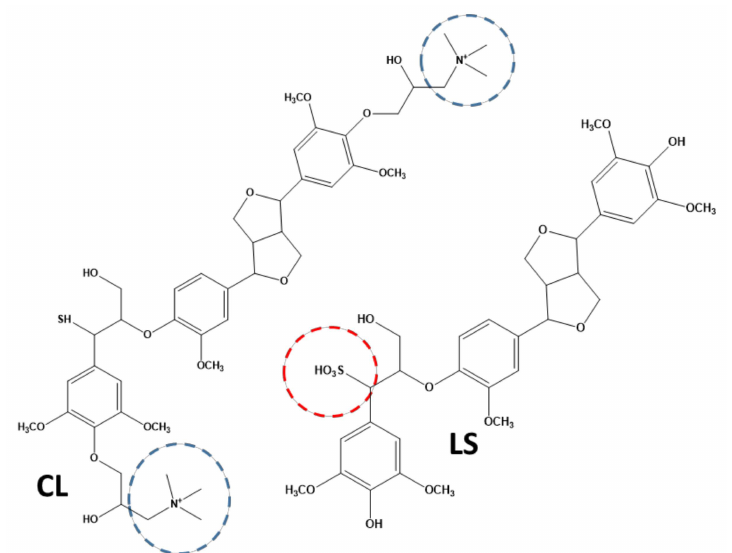
Figure 2. Schematic representation of cationic eucalyptus lignin (CL) and eucalyptus lignosulphonates (LS). The quaternary ammonia and sulfonic groups outlined by blue and red circles,